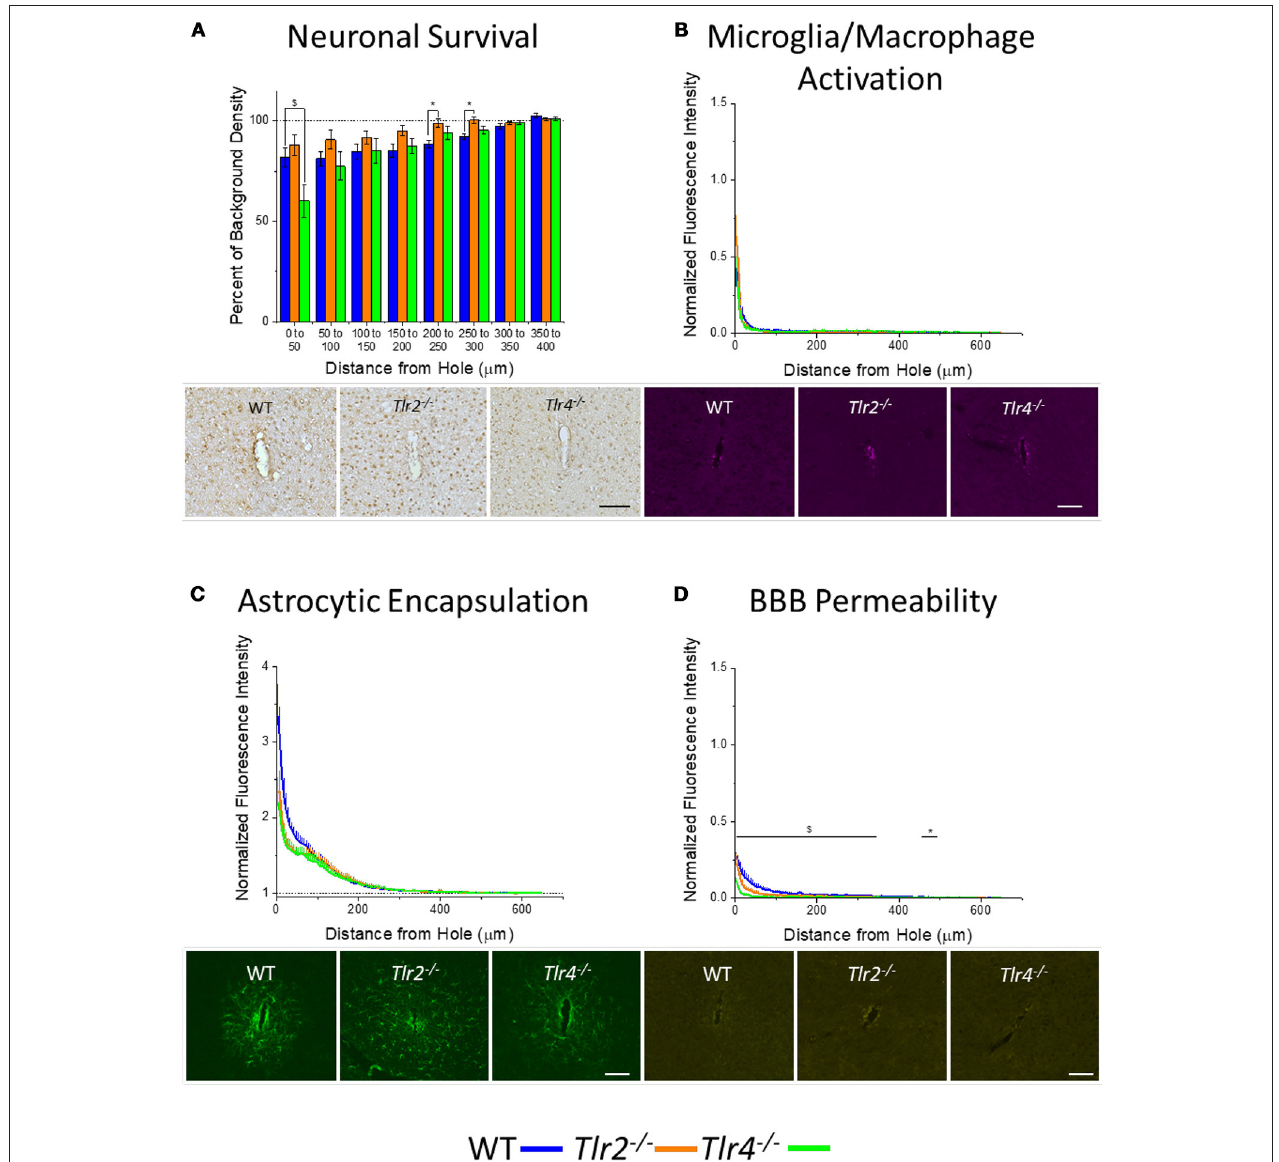
FIGURE 3 | Chronic immunohistochemical evaluation of Tlr2 − / − , Tlr4 − / − , and wildtype mice 16 weeks after probe implantation. (A) Neuronal survival in cortical tissue around implanted probes presented as percent of background density with respect to distance from probe hole ( µ m). Neuronal survival in Tlr4 − / − mice was significantly lower than neuronal survival in wildtype mice in the distance interval 0–50 µ m from the probe hole. Neuronal survival in Tlr2 − / − mice was significantly higher than neuronal survival in wildtype mice in the distance intervals 200–250 and 250–300 µ m from the probe hole. Tlr2 − / − : N = 5; Tlr4 − / − : N = 5; WT: N = 7. (B) Microglia and macrophage activation in cortical tissue around implanted probes presented as normalized fluorescence intensity with respect to distance from probe hole ( µ m). Normalized fluorescence intensity indicates expression of CD68. No significant differences were observed between either of the knockout conditions and wildtype mice. Tlr2 − / − : N = 5; Tlr4 − / − : N = 5; WT: N = 7. (C) Astrocyte encapsulation in cortical tissue around implanted probes presented as normalized fluorescence intensity with respect to distance from probe hole ( µ m). Normalized fluorescence intensity indicates expression of GFAP. No significant differences were observed between either of the knockout conditions and wildtype mice. Tlr2 − / − : N = 5; Tlr4 − / − : N = 5; WT: N = 7. (D) Blood-brain barrier permeability presented as normalized fluorescence intensity with respect to distance from probe hole ( µ m). Normalized fluorescence intensity indicates expression of IgG. Tlr4 − / − mice exhibited significantly less IgG expression within each distance interval examined from of 0-350 µ m from the probe hole, indicating reduced blood-brain barrier permeability, $ p < 0.05. Additionally, Tlr2 − / − mice exhibited significantly less IgG expression within a distance of 450–500 µ m from the probe hole, indicating reduced blood-brain barrier permeability, * p < 0.05. Tlr2 − / − : N = 5; Tlr4 − / − : N = 5; WT: N = 7. Tlr2 − / − : N = 5; Tlr4 − / − : N = 4; WT: N = 6. Orange = Tlr2 − / − , Green = Tlr4 − / − , and Blue = WT. Scale bars are provided for each set of images, scale = 100 µ